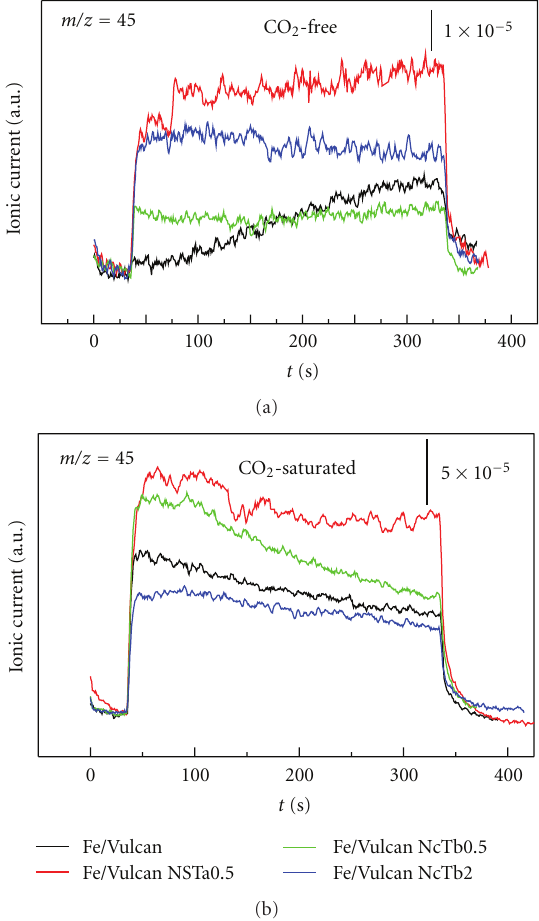
Figure 7: MSTs for CO 2 -free (a) and CO 2 saturated (b) solution in 0.5M H 2 SO 4 on Fe/C catalysts ( E i = − 0 . 2V, E f = − 1 . 8 versus